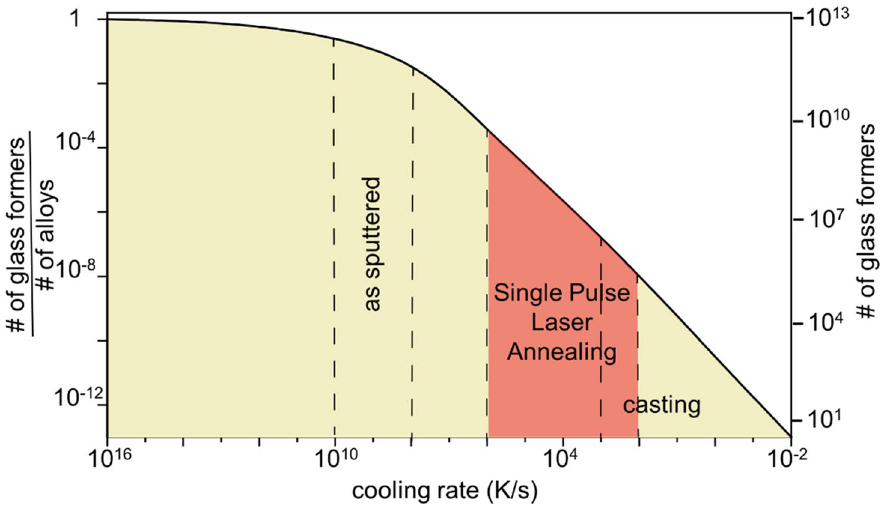
Figure 4. Order of magnitude estimation of the potential number of glass formers as fractions of the total number of alloys for different cooling rates. Data is estimated for quinary systems including all the lower order systems from 32 glass forming elements 4 . For cooling rates above ~ 10 16 K/s all alloys and even